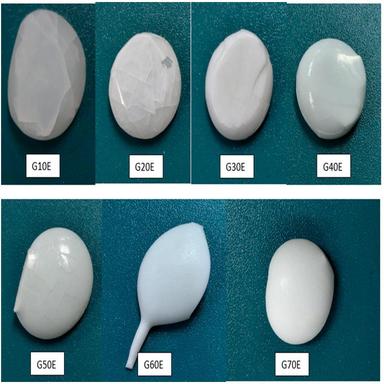
Visual observation of the investigated glasses after heat-treatment at 550◦C, 2h then at 800◦C, 2h.